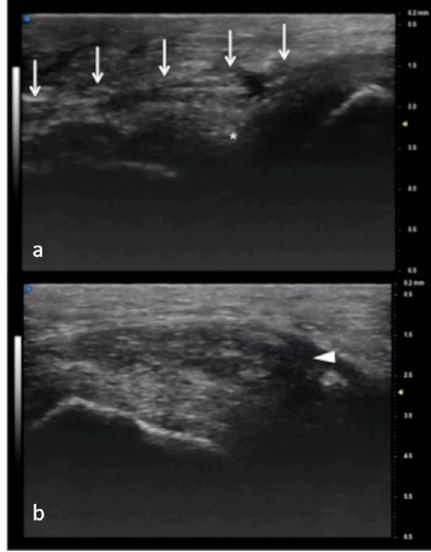
Figure 7. Full-thickness UCL tear. In ( a ), normal appearance of adductor pollicis aponeurosis (white arrows) and below the ulnar collateral ligament (asterisk) of the first metacarpophalangeal joint. In ( b ), the non-visualization of the ulnar collateral ligament and the presence of a mass-like area (arrowhead) proximal to the joint have high accuracy in depicting a displaced full-thickness ligament tear.